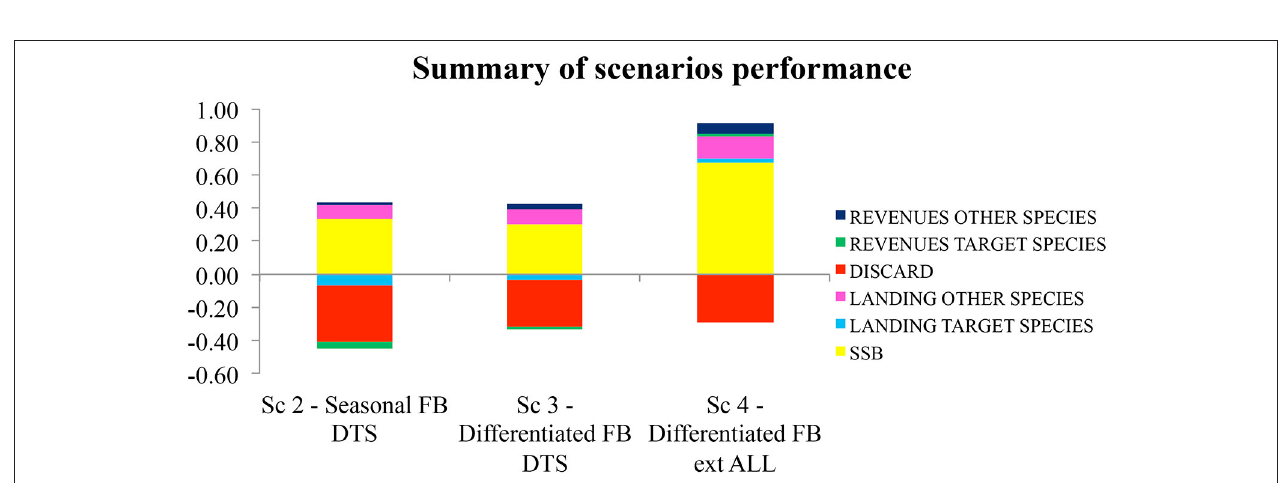
FIGURE 9 | Summary of the performance of the management scenarios compared to the status quo (difference in %) considering the following model-based indicators: spawning stock biomass (SSB), landing of target species, landing of other species, discards, revenues of target species, and revenues of other species.